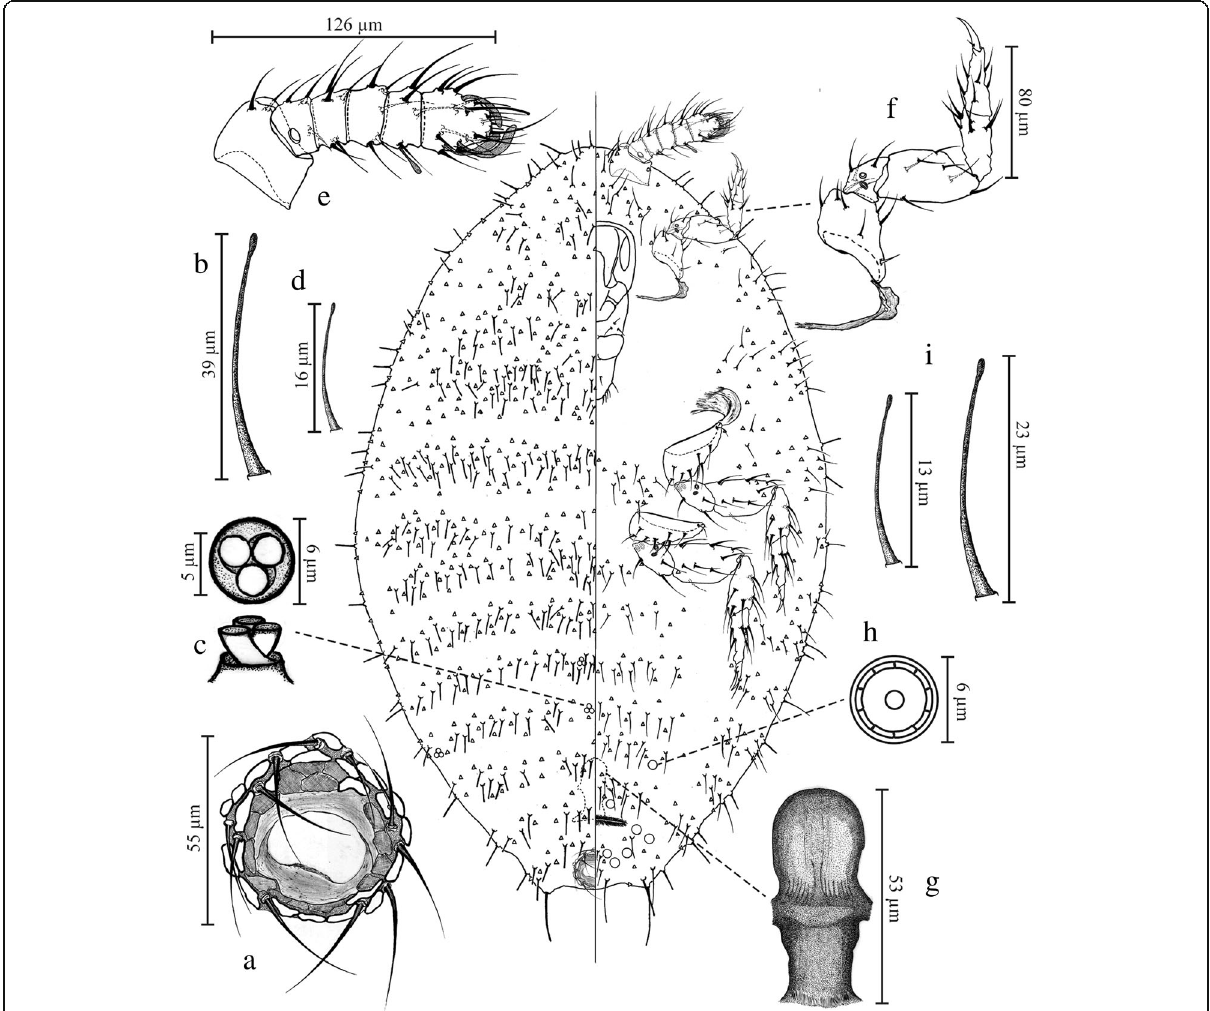
Fig. 1 Taxonomic illustration of Williamsrhizoecus coffeae Caballero and Ramos with dorsal features shown on the left side and ventral features on the right side. Around the outside of the drawing are enlarged details and measurements of the anal ring ( a ), anal lobe clavate setae ( b ), a tritubular cerore ( c ), dorsal clavate setae ( d ), antennae ( e ), fore leg ( f ), the genital chamber ( g ), multilocular disc pore ( h ), and ventral clavate setae ( i